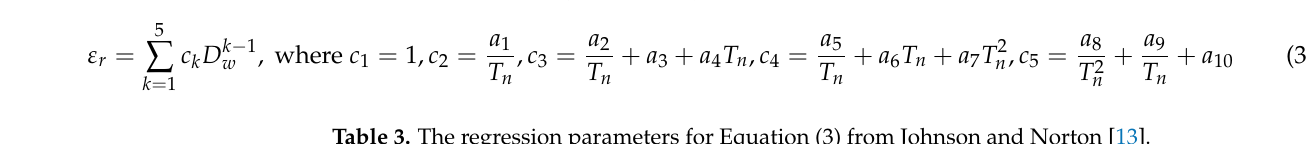
Table 3. The regression parameters for Equation (3) from Johnson and Norton